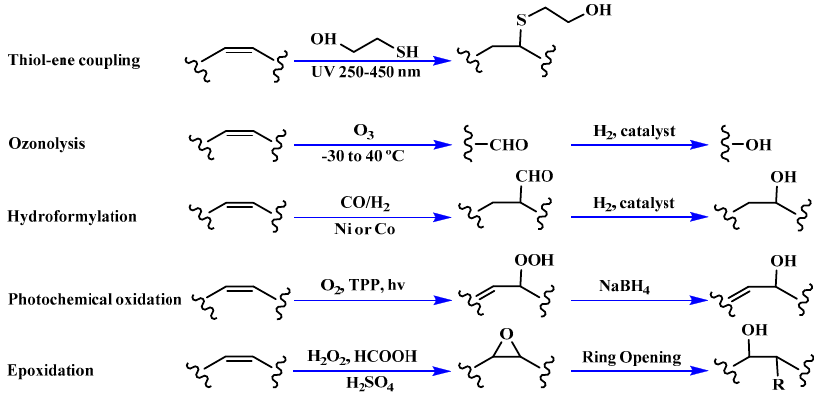
Figure 2. Synthesis of bio-based polyols derived from vegetable oils [77].